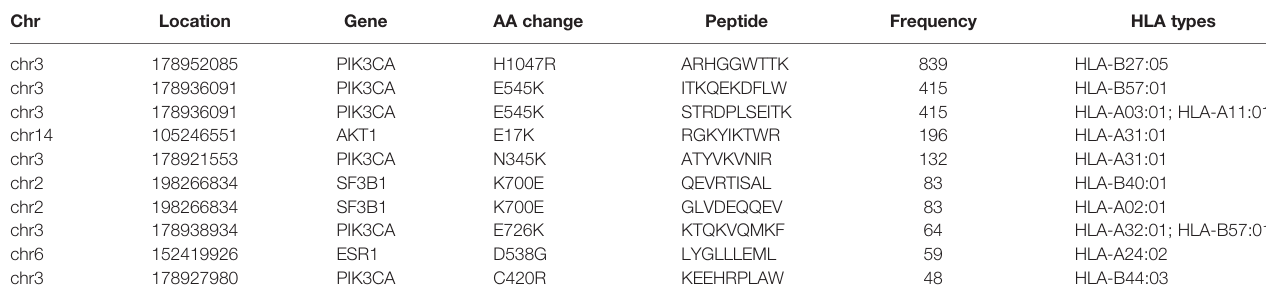
TABLE 1 | Top 10 SNVs and corresponding